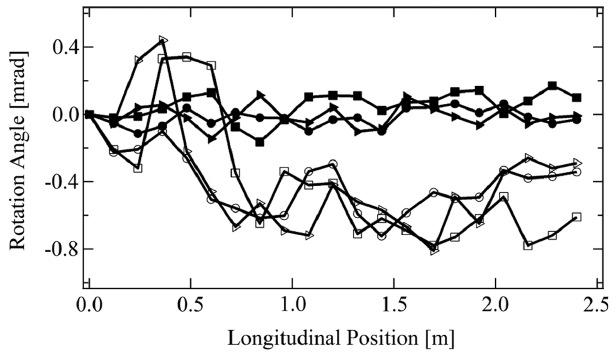
FIG. 9. Hall probe rotation angle versus longitudinal position. (Filled circle) θ after corrections, (filled square) θ after s z corrections, (filled right triangle) θ after corrections, (open x circle) θ before corrections, (open square) θ before corrections s z (open right triangle) θ before corrections. x